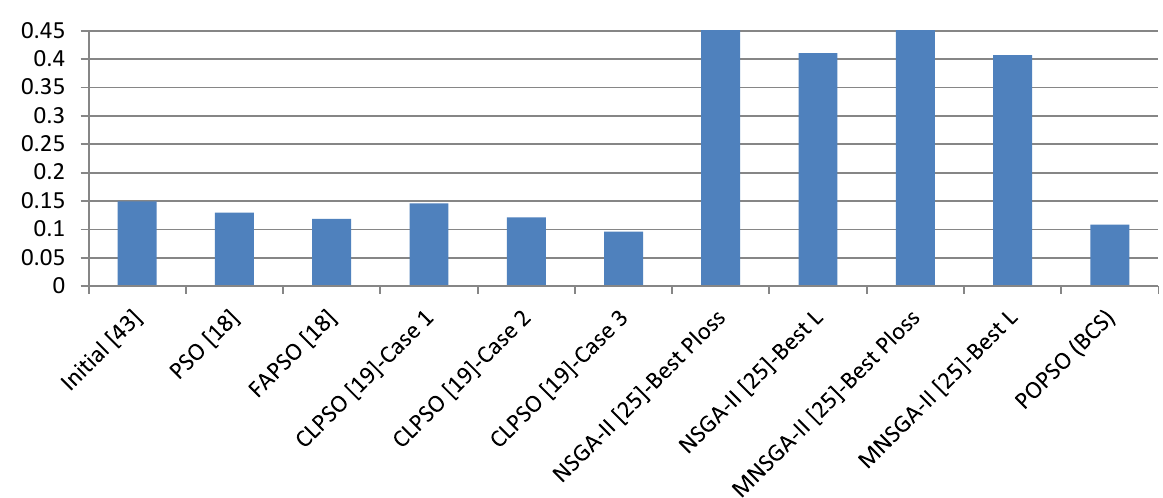
Figure 14. Comparison results of L- index in IEEE 118-bus test